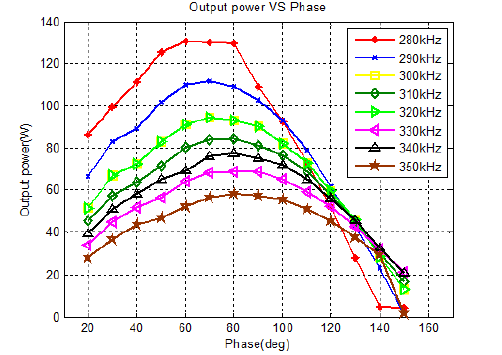
Figure 25. Output power vs. phase under different